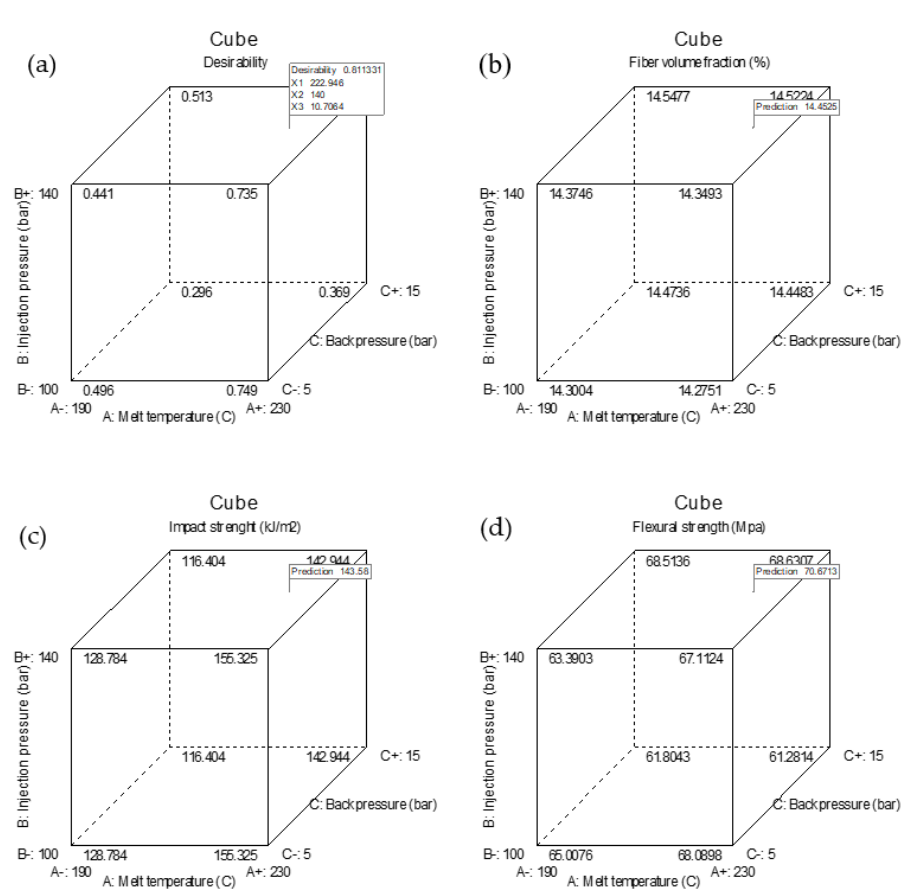
Figure 15. Optimized responses prediction: ( a ) desirability; ( b ) fiber volume fraction; ( c ) impact strength; and ( d ) flexural strength.